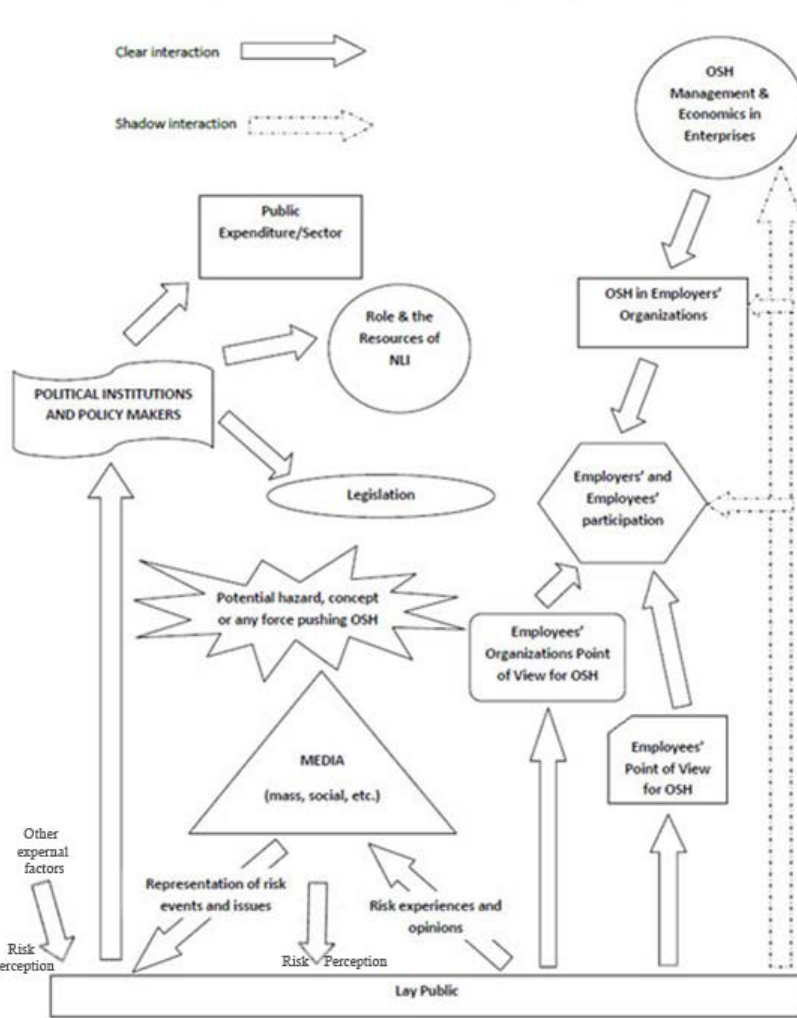
Figure 1. Model of risk communication across the OSH levelling